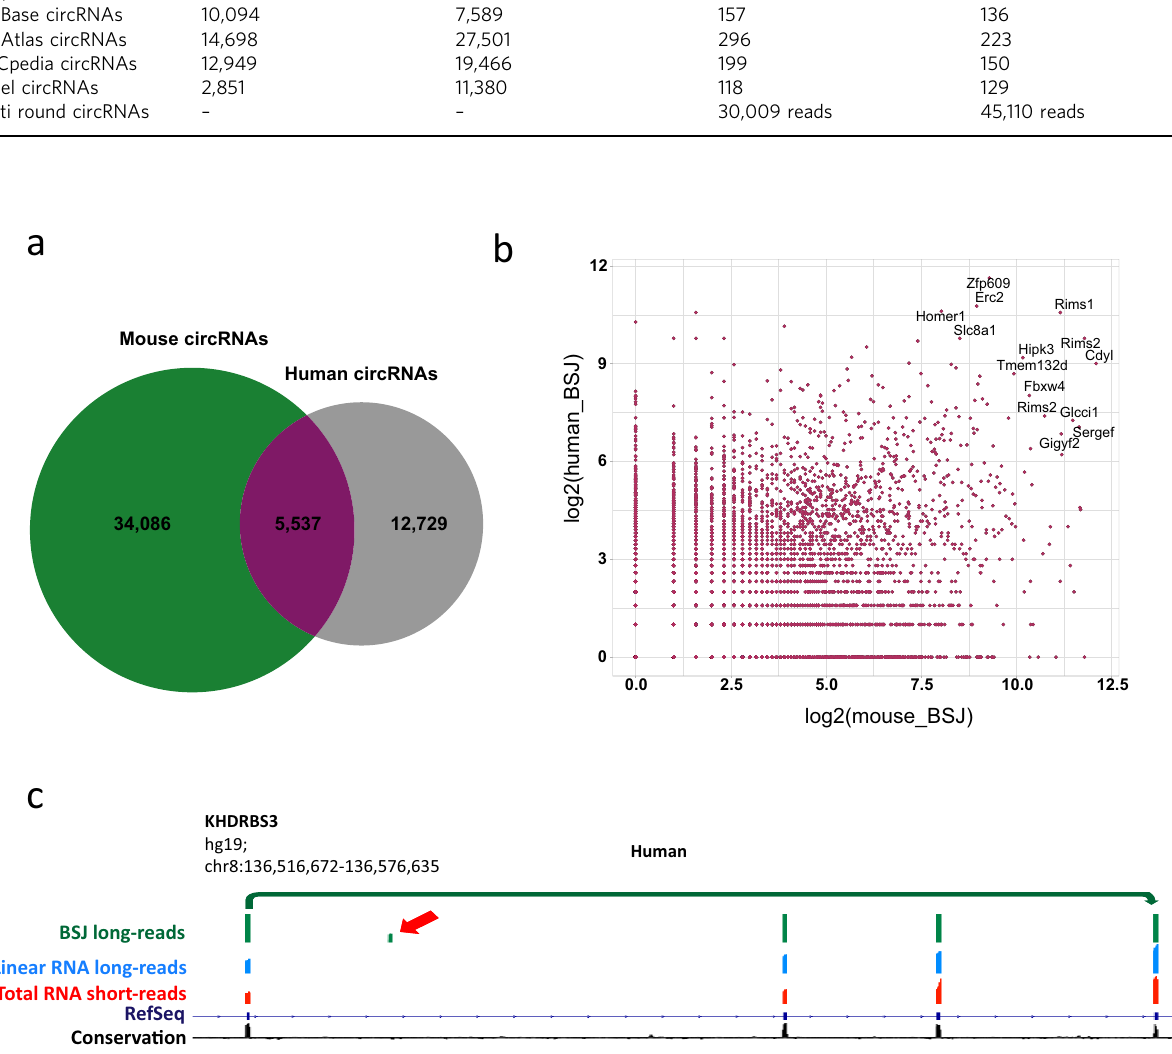
Fig. 2 Conservation between human and mouse brain-derived circRNAs. a Venn diagram showing the total number of circRNAs found in either human (18,266) or mouse (39,623) or in both (5,537). b The number of BSJ-spanning reads detected for mouse ( x -axis) vs. human ( y -axis) circRNAs. Only circRNAs that are conserved between human and mouse are included. Some genes like Rims1 generate several different circRNAs. c Gene map of human circKHDRBS3, shown as an example where a novel exon (indicated by red arrow) is only detected by ONT sequencing (BSJ long-reads). The green track indicates the BSJ reads in human brain. The light blue track represents reads from full-length linear mRNA sequencing by ONT and the red track indicates short-read sequencing reads for the corresponding sample. The dark blue line refers to RefSeq gene annotation and the black track indicates the level of